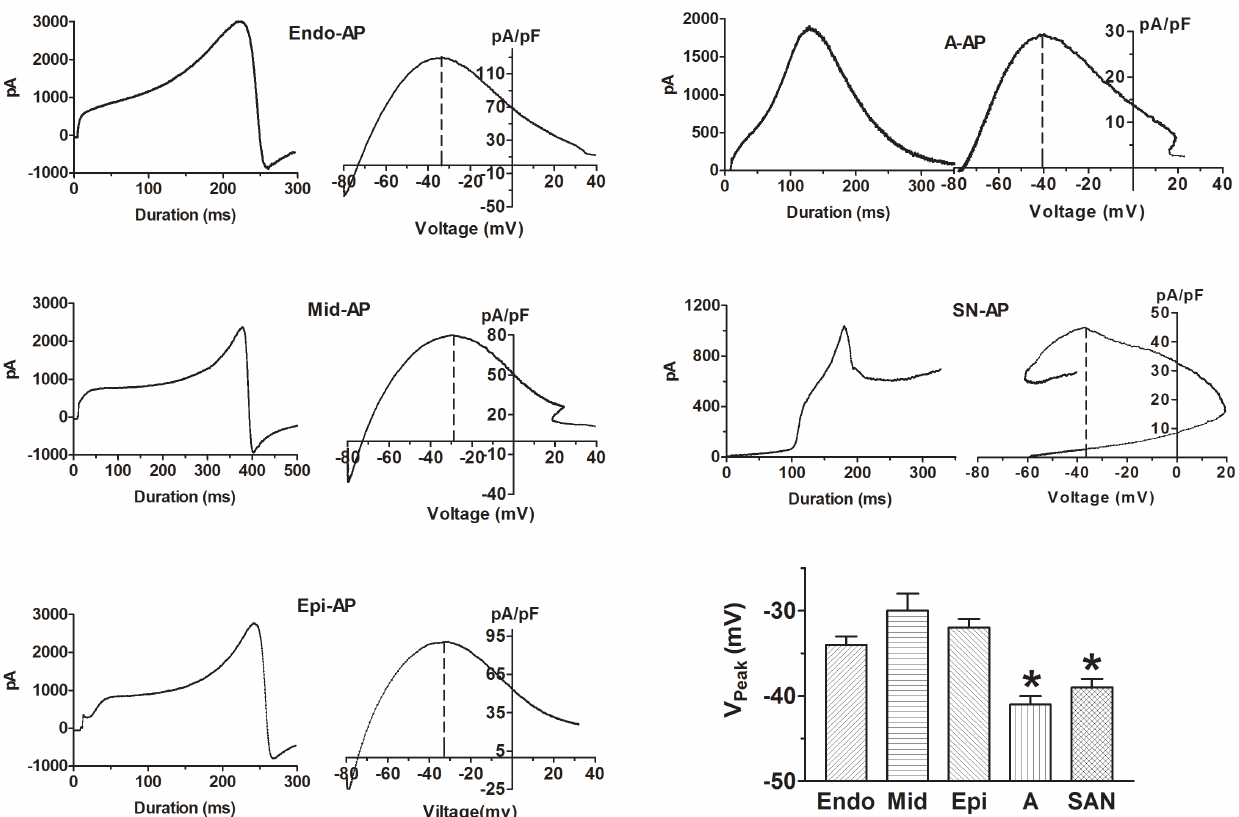
Figure 3. I HERG waveforms and I–V relationships measured by AP-clamp. Left panels: Typical examples of current waveforms recorded by AP-clamp; Right panels: I–V relationships averaged from at least 15 cells. Dash lines indicate the voltages at which I HERG peaks (V Peak ). The mean V Peak was averaged from 15 cells for each group. * p , 0.05 vs. Endo.